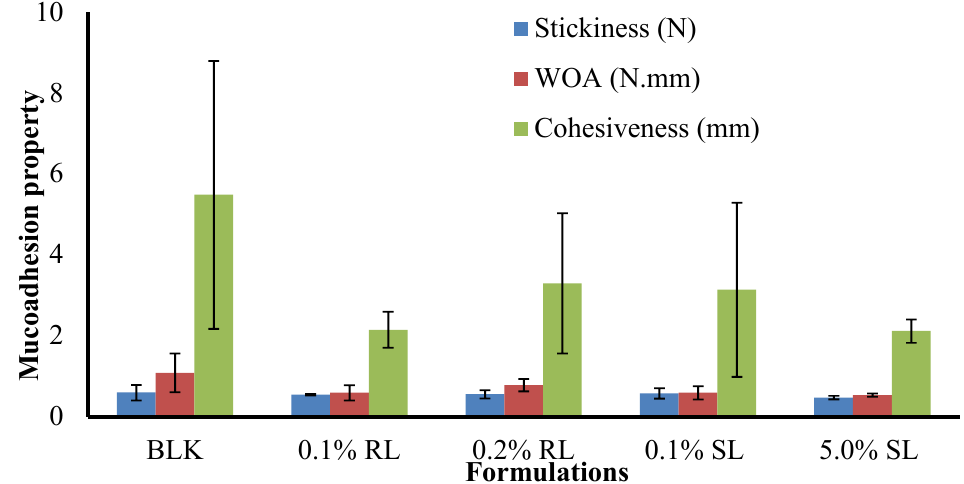
Figure 10. Comparison of the adhesive properties (stickiness, work of adhesion and cohesiveness) of BLK and DL composite 1.5% CARR:SA (1:3) wafers.